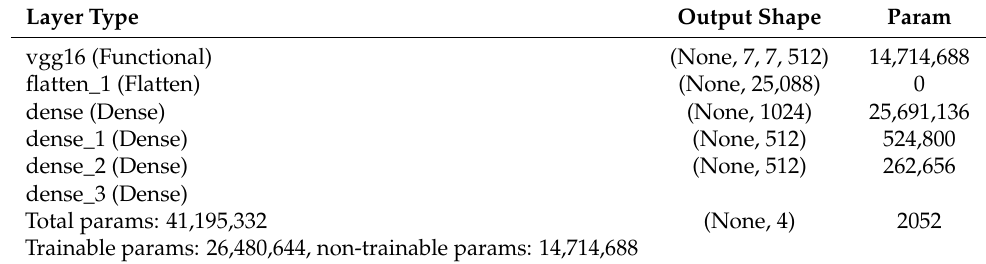
Table 5. VGG16 Fine Tuning